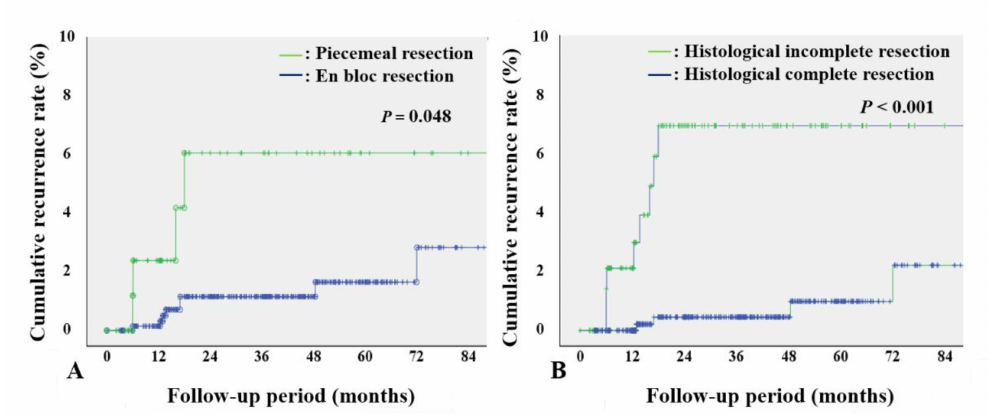
Figure 3. Cumulative recurrence rates according to risk factors. ( A ) Cumulative recurrence rates after piecemeal and en bloc endoscopic submucosal dissection. ( B ) Cumulative recurrence rates after histological complete and incomplete resection.